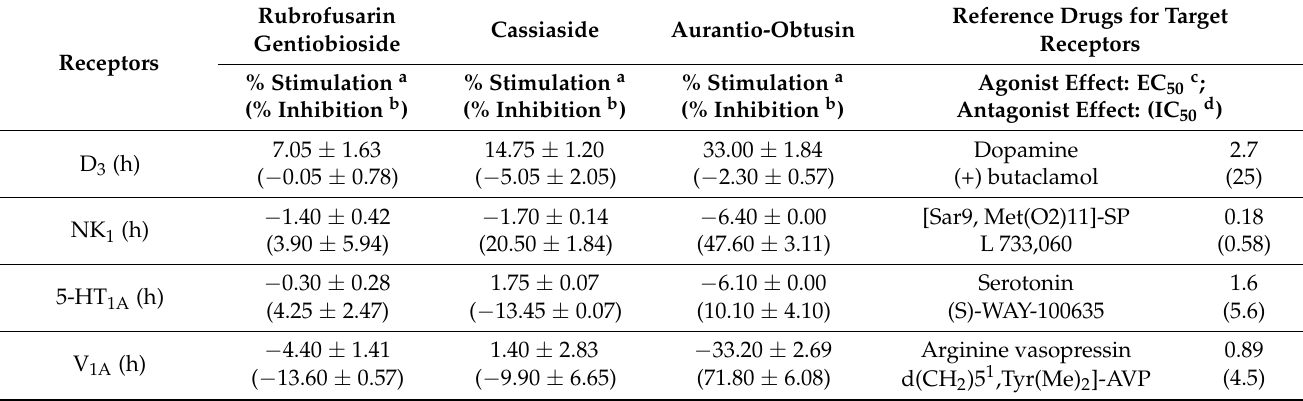
Table 1. Efficacy values (% stimulation and % inhibition) of Cassia compounds on various GPCRs at 100 µ M.